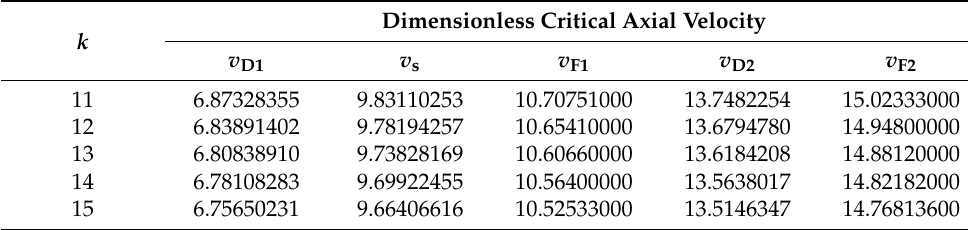
Table 7. The effects of gradient parameter k of material on the dimensionless critical axial velocities of FGM beam